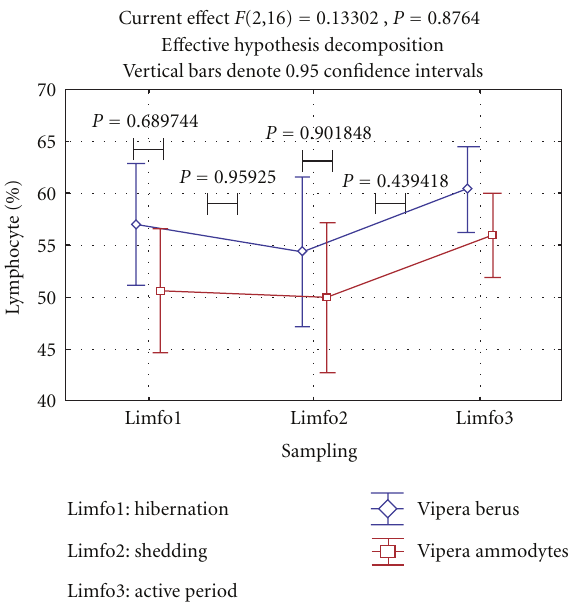
Figure 2: Changes in lymphocyte populations in V. berus berus and V. ammodytes ammodytes during hibernation, shedding, and active